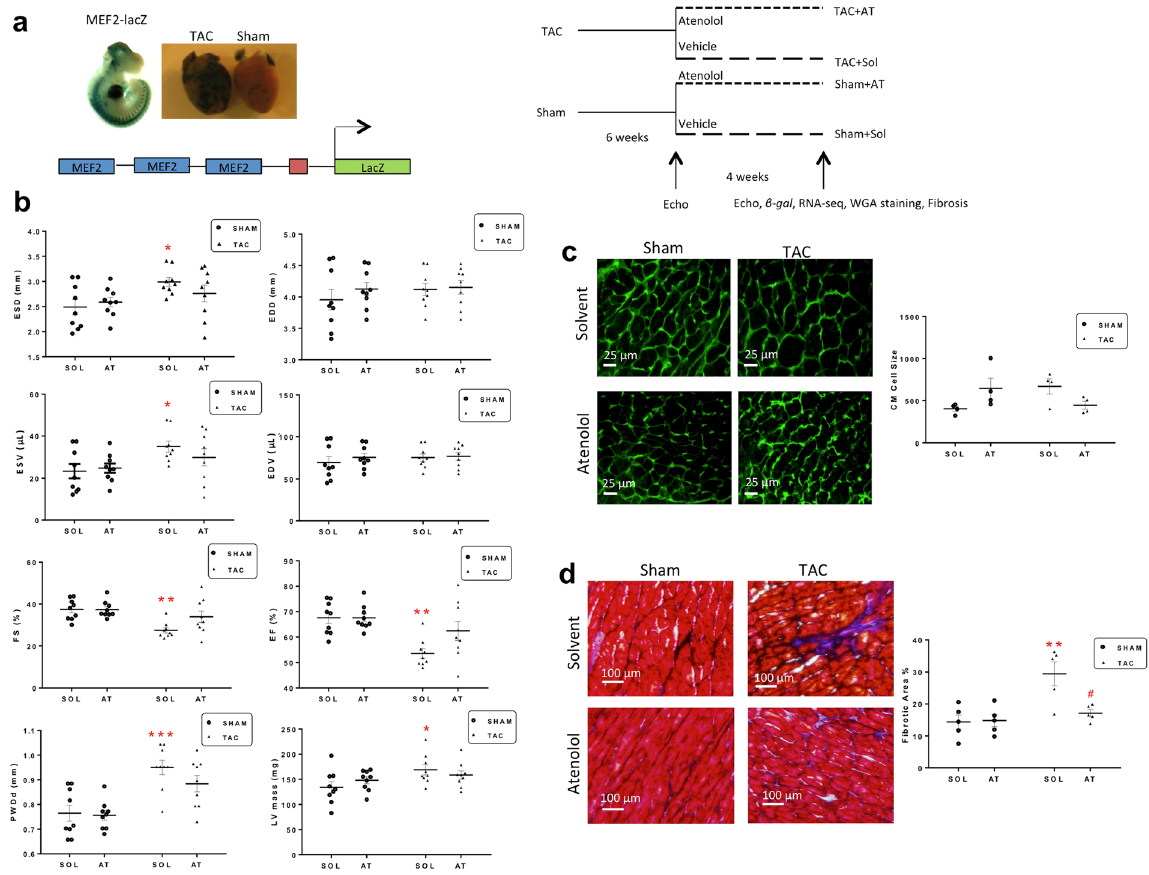
Figure 1. Atenolol reverses heart failure symptoms in TAC mice. ( a ) Experimental design overview. MEF2- LacZ mice (6–8 weeks old) underwent transverse aortic constriction (TAC) or Sham surgeries, followed by Solvent or Atenolol (50 mg/kg/day) treatment (n = 9). ( b ) Functional analysis of TAC or Sham mouse hearts after four weeks of Atenolol or Solvent treatment. End systolic diameter (ESD), end diastolic diameter (EDD), ejection fraction (EF), fractional shortening (FS), end systolic volume (ESV), end diastolic volume (EDV), left ventricular mass (LV), and left ventricular posterior wall depth (PWDd) were assessed by ultrasound echocardiography. (n = 9), Data are presented as mean ± SEM. * P < 0.05 ** P < 0.01 *** P < 0.001 vs Sham + Sol. ( c ) WGA stain depicting cardiac hypertrophy. Images are representative of an average of n ≥ 10 images per heart, 4 animals per group. Scale bar: 25 µ m. Graph below shows cardiomyocyte size (CM cell size), quantified based on an average of ≥ 10 cell measurements per mouse (n = 4). ( d ) Masson’s Trichrome stain depicting fibrosis. Images are representative of n = 10 images per heart, 5 animals per group. Cardiomyocytes appear red, nuclei appear black and collagen appears blue. Scale bar: 100 µ m. Graph shows quantified cardiomyocyte fibrosis based on a three representative images per mouse (n = 5). Data are presented as mean ± SEM. ** P < 0.01 vs Sham + Sol. # P < 0.05 vs TAC +